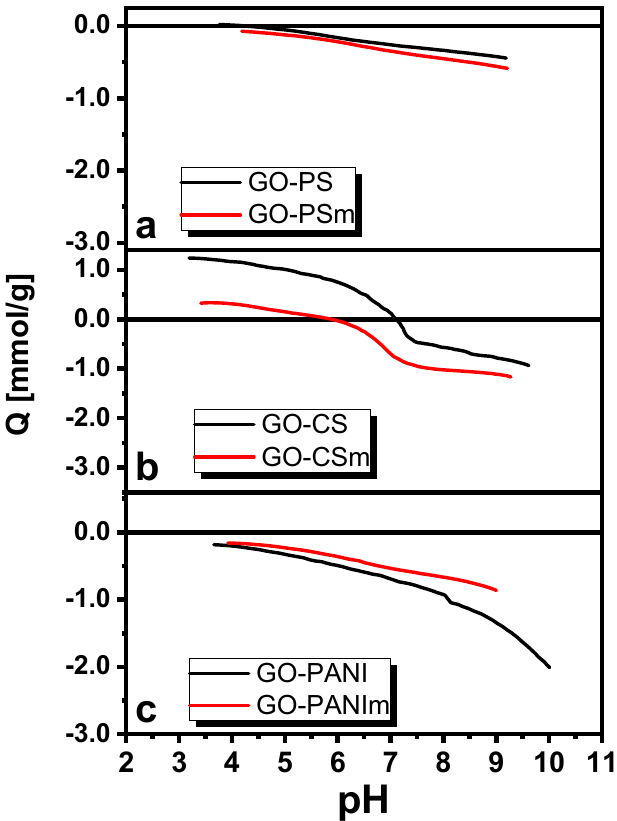
Figure 7. Potentiometric titration results for ( a ) GO–PS and GO–PSm, ( b ) GO–CS and GO–CSm, ( c ) GO–PANI and GO–PANIm.